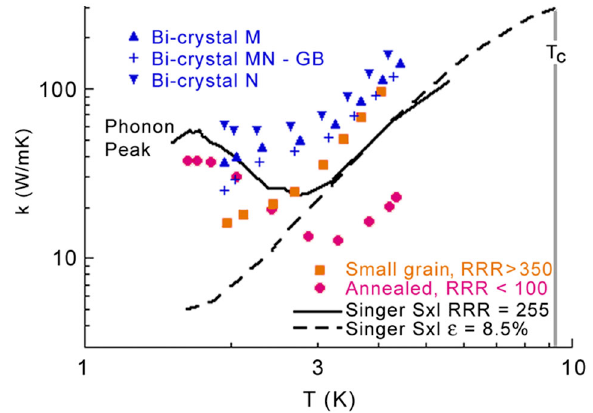
FIG. 18. (Color) Measurement of thermal conductivity, k : the two curves from Singer [45] show how strain in a single crystal removes the phonon peak. An as-received polycrystal (orange symbols) showed no phonon peak, but after a 1400 (cid:1) C anneal, the phonon peak returned, but due to a low quality vacuum, the thermal conductivity at higher T dropped extensively. A bicrystal specimen (blue symbols) shows modest effects of grain orienta- tion and boundary on k